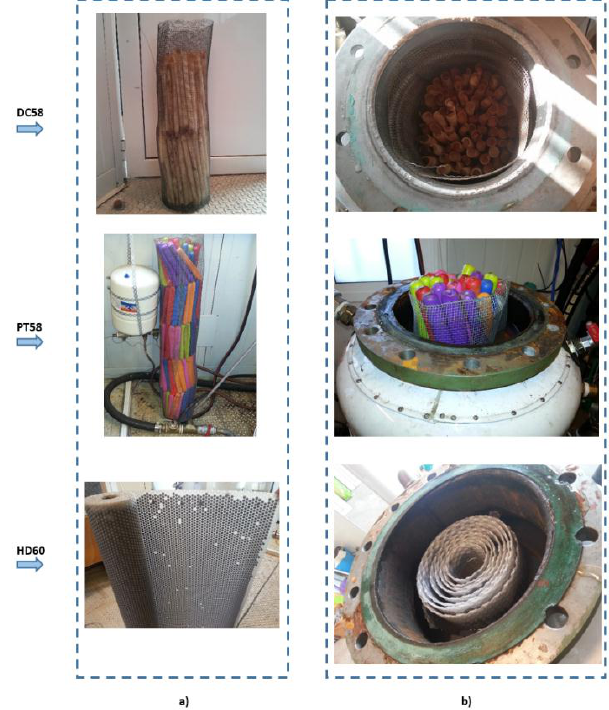
Figure 1. Photographs of the different PCMs studied. ( a ) Positioning; ( b ) in the test tank.